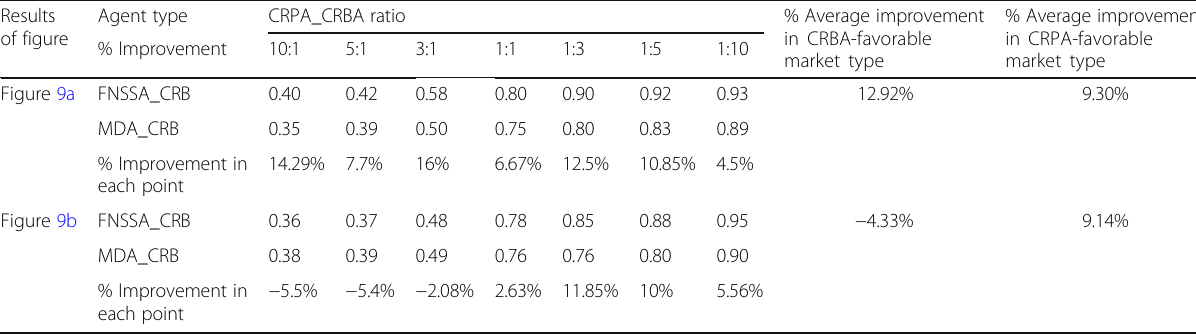
Table 8 Analysis of the results obtained from Fig. 9a-b Results Agent of figure